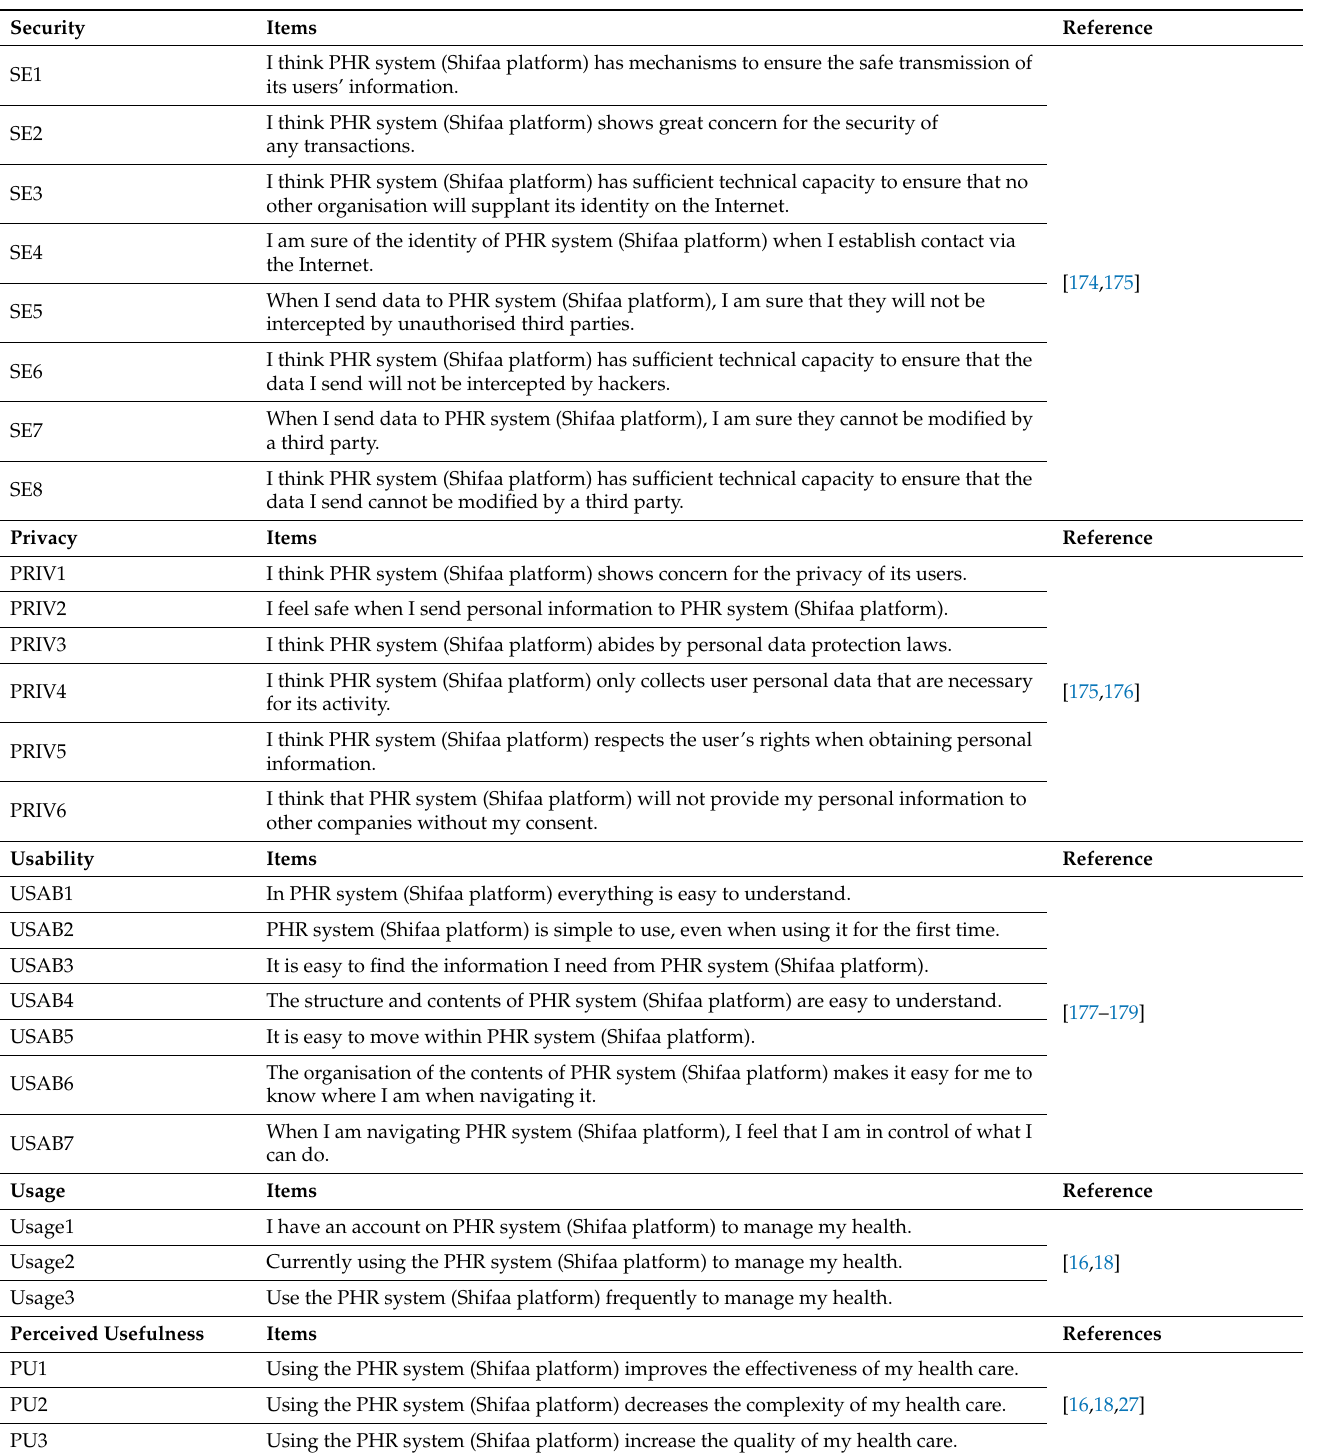
Table A1. Variables with measurement items